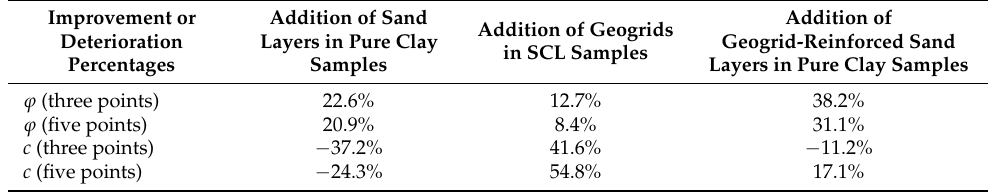
Figure 14. The variation in the shear strength index of the samples with the thickness of sand layers. Table 2. The comparison between the shear strength index of the pure clay sample, the SCL sample, and the LGSCR